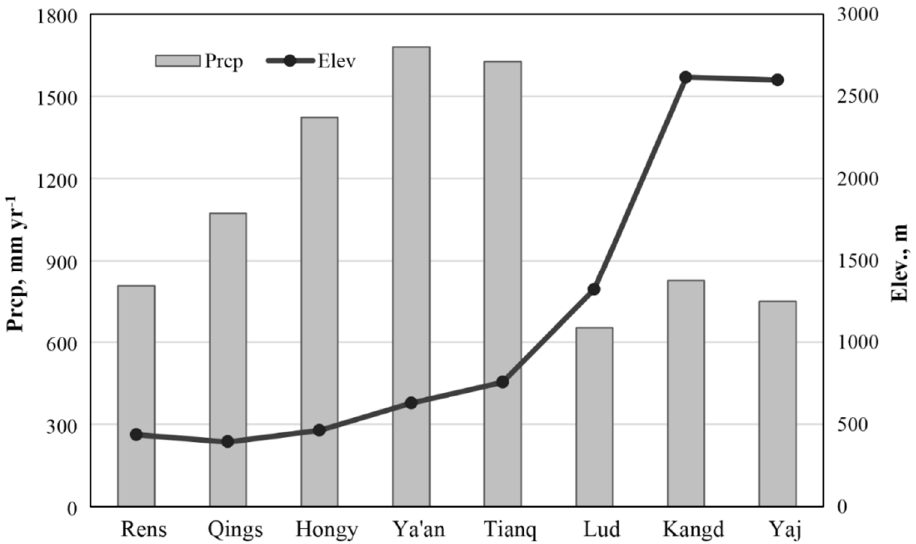
Figure 3. Variations in annual precipitation across the weather sites on the latitudinal elevation transect in the study area.